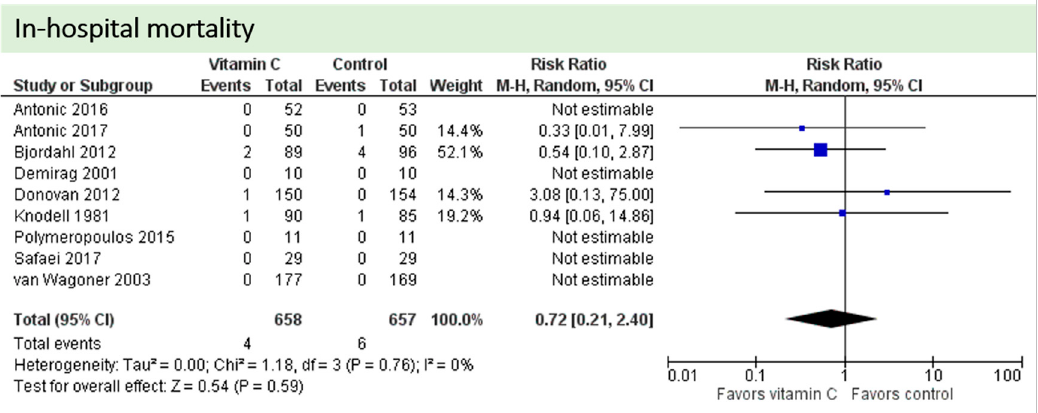
Figure 7. In-hospital mortality.